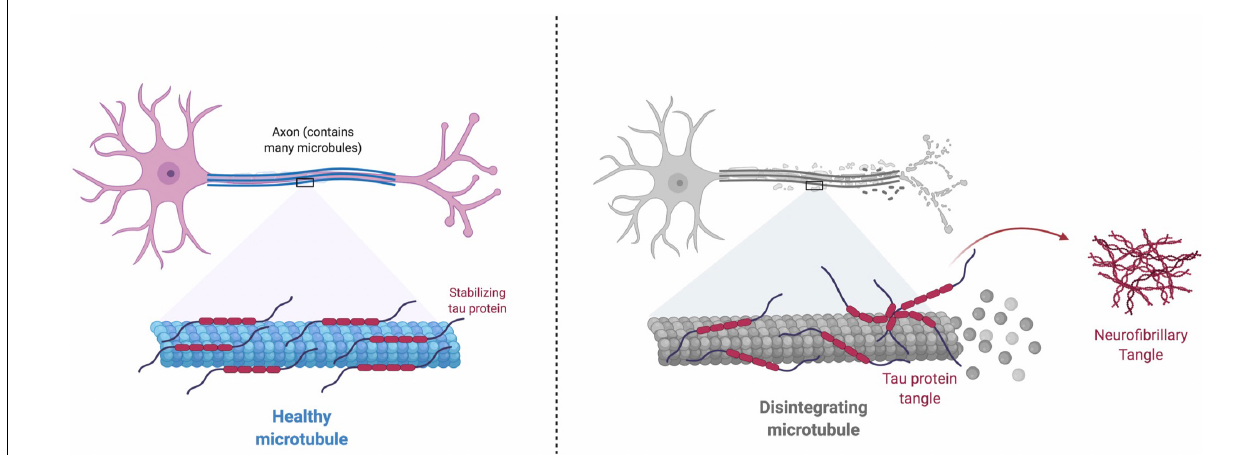
FIGURE 2 | Healthy Microtubule: Tau protein binds and stabilizes microtubules. The attachment of tau to microtubules is regulated through a balanced phosphorylation by kinases (e.g., Cdk5, GSK3 β , MARK and ERK2) and dephosphorylation by phosphatases (e.g., PP1, PP2A, PP2B, and PP2C). Disintegrating Microtubule: Under pathological conditions, equilibrium between the roles of kinases and phosphatases is disrupted, and increase in the kinase activity and decrease in the phosphatase activity will cause tau hyperphosphorylation. Hyperphosphorylated tau protein is misfolded and leads to more organized aggregates, which eventually develops neurofibrillary tangles inside neurons. Neurofibrillary tangles impair normal axonal transport, disrupt synaptic plasticity, and induce cell